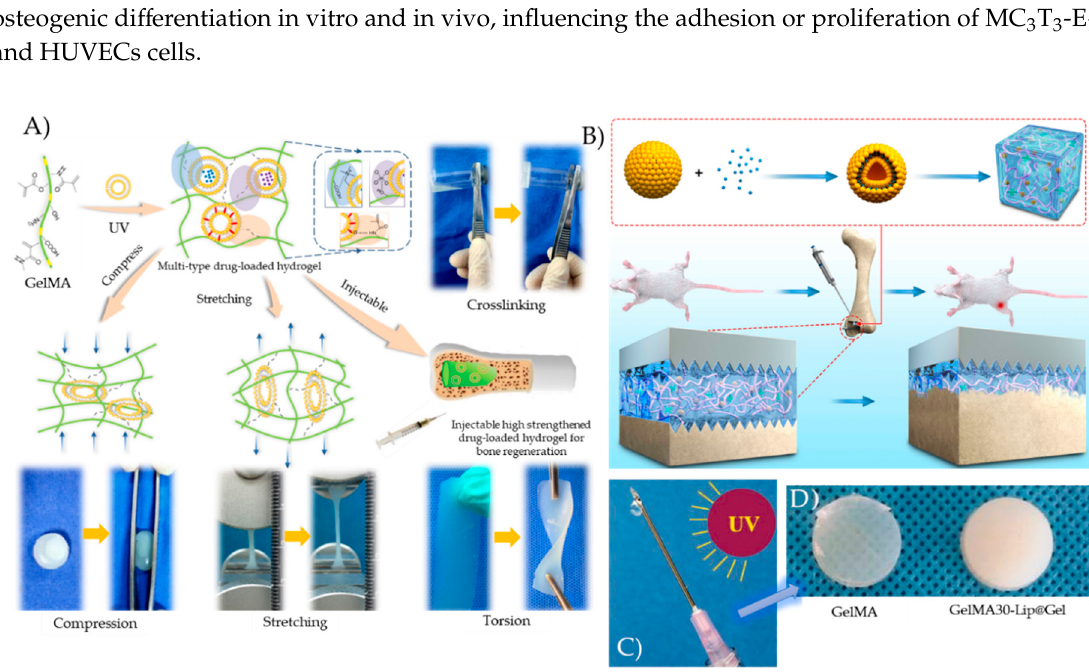
Figure 3. ( A ) Liposome-GelMA hydrogel with controlled release of bone regeneration drugs